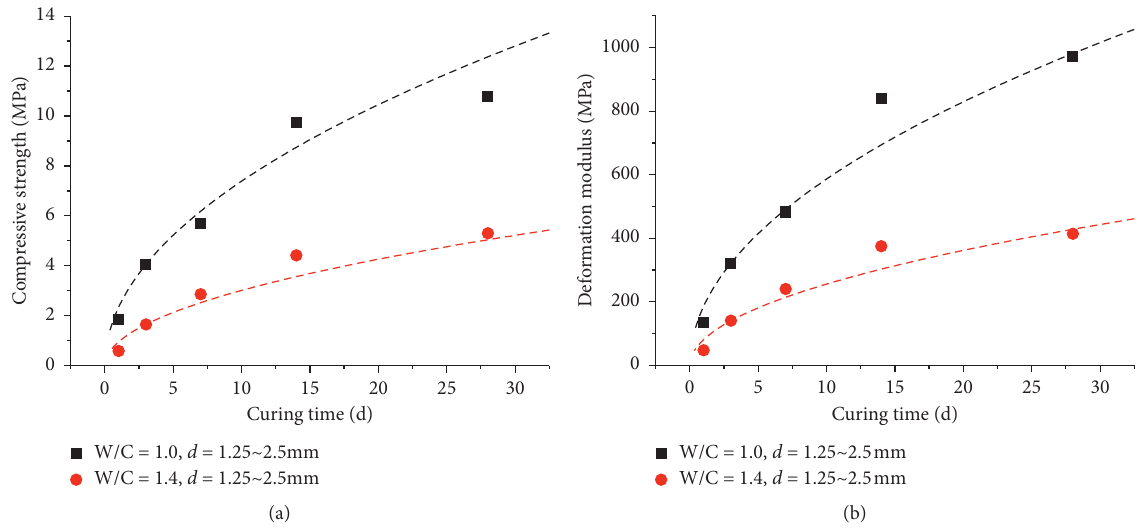
Figure 12: Fitting curves of mechanical parameters of the grouted body and curing time. (a) Compressive strength. (b) Deformation